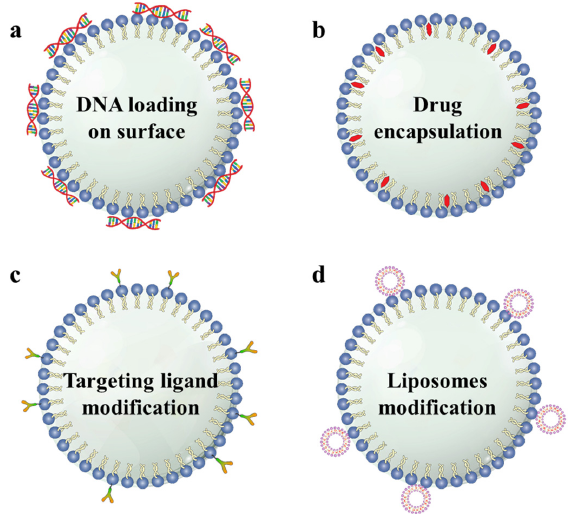
Figure 1. Structure of phospholipids used in microbubble synthesis. (DPPA, dipalmitoyl phosphoric acid; DPPE, dipalmitoylphosphatidylethanolamine; DPPC, dipalmitoylphosphatidylcholine; DPPG, dipalmitoylphosphatidylglycerol; DSPC, distearoylphosphatidylcholine; DSPG, dis ‐